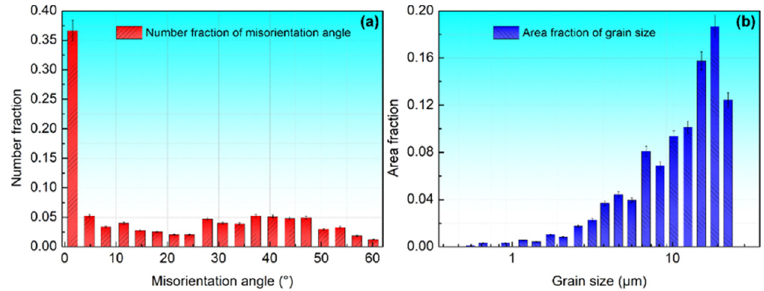
Figure 2. ( a ) Misorientation angle and ( b ) grain size distribution of the SLMed AlSi10Mg alloy.